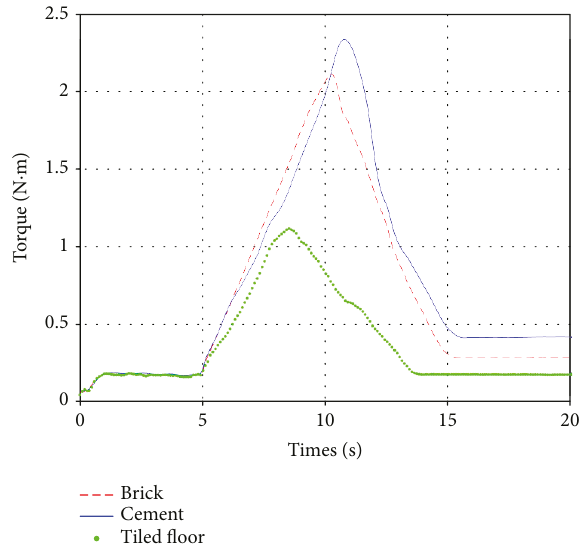
Figure 12: The dynamic simulation results of the output torque in the transformable process.